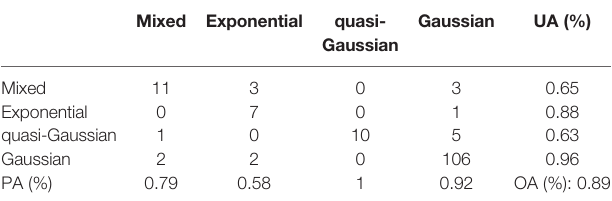
TABLE 2 | Confusion matrix of Chl-a vertical pro fi le classi fi cation (UA denotes the user accuracy and PA denotes the producer accuracy). Mixed Exponential quasi- Gaussian UA (%) Gaussian